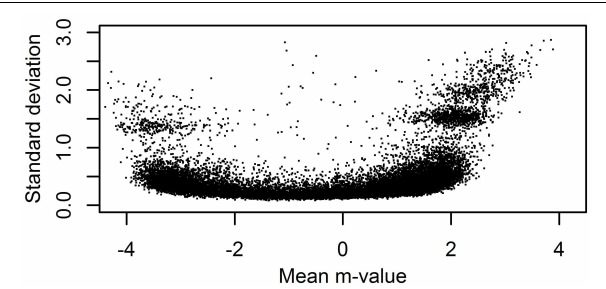
FIGURE 2 | Heteroscedasticity of m -values. For a single 450K sample from the ESTHER study with unsummarized intensities the standard deviation and mean of single-bead m -values for probes in P 2 with at least 20 beads on the chip were computed.